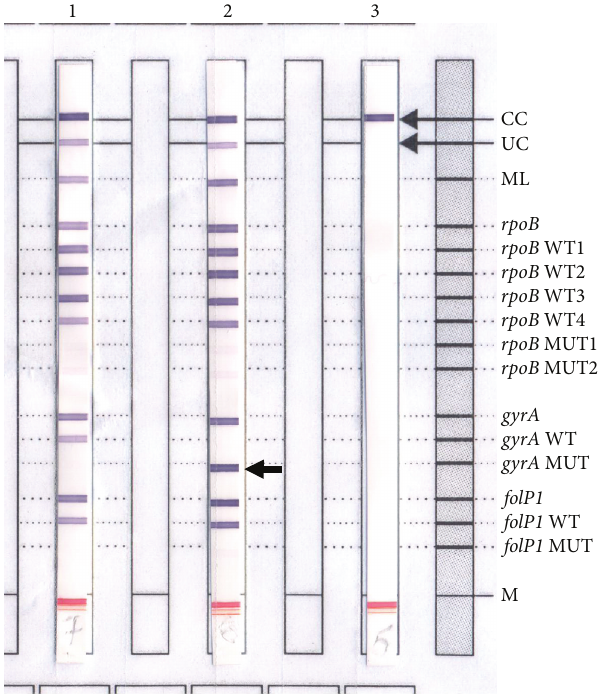
Figure 2: GenoType LepraeDR DNA strip test to assess drug resistance of Mycobacterium leprae . Lane 1, positive control using M. leprae wild-type strain with rpoB , gyrA , and folP1 alleles. Lane 2, M. leprae strain of the case with gyrA mutation (A91V) and resistant to fluoroquinolone (arrow). Lane 3, negative